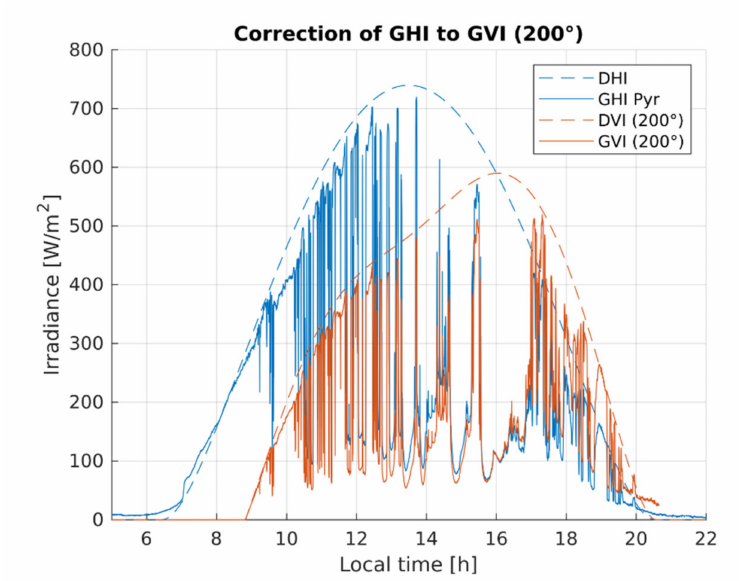
Figure 1. Correction of GHI to GVI on a 200 ◦ facing angle. Note that the theoretical values for DHI and DVI were calculated according to [8] and were used to correct the measured GHI data to infer the irradiance on the vertical standing wall structures